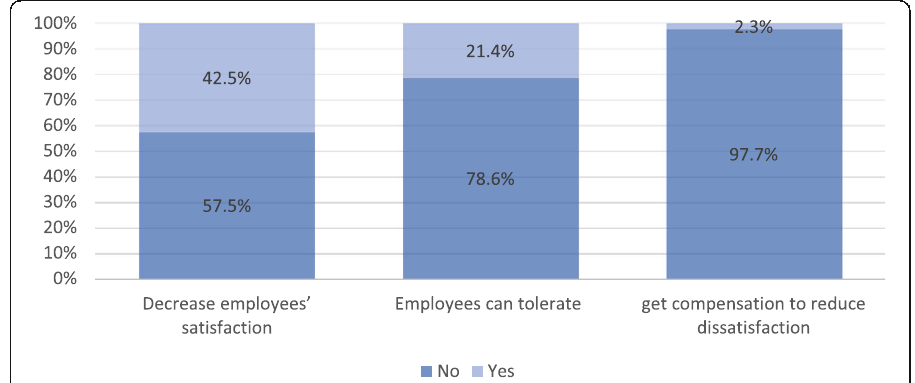
Fig. 9 The percentage of surveyed managers ’ beliefs on employees ’ satisfaction due to dynamic control. N =